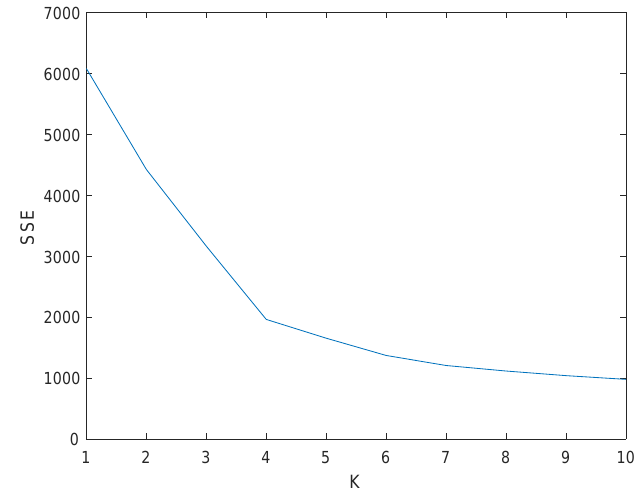
Figure 7. Cluster parameter K versus